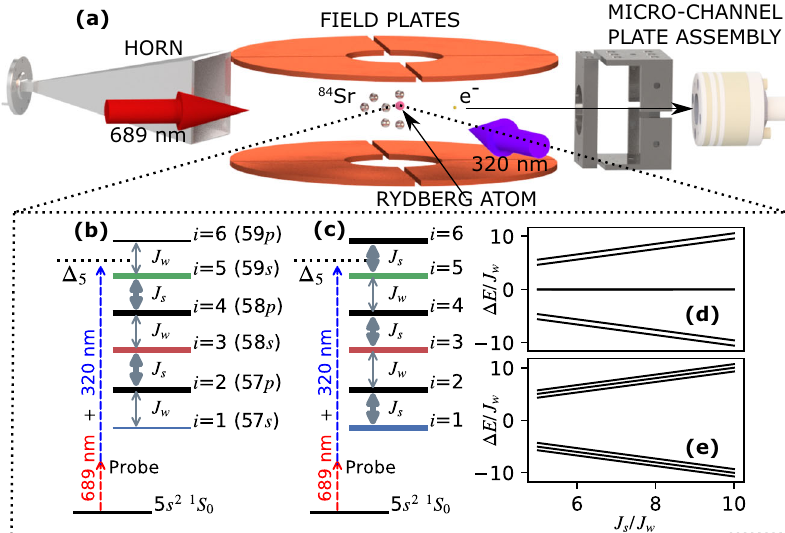
Fig. 1 Implementing the six-site Su-Schrieffer-Heeger (SSH) model. ( a ) Experimental schematic. ( b ) and ( c ) represent realizations of the SSH model using six Rydberg levels of 84 Sr that, respectively do and do not possess topologically protected edge states (TPS). Double-headed gray arrows denote near-resonant millimeter-wave couplings, which induce tunneling between sites of the synthetic lattice, and thicker lines correspond to faster tunneling. Dashed lines show two-photon excitation to a Rydberg level of interest. ( d , e ) show band structure for ( b ) and ( c ) respectively vs. the ratio of strong and weak tunneling amplitudes, J s / J w . The site-numbering convention is given in ( b ), with odd numbers corresponding to ns